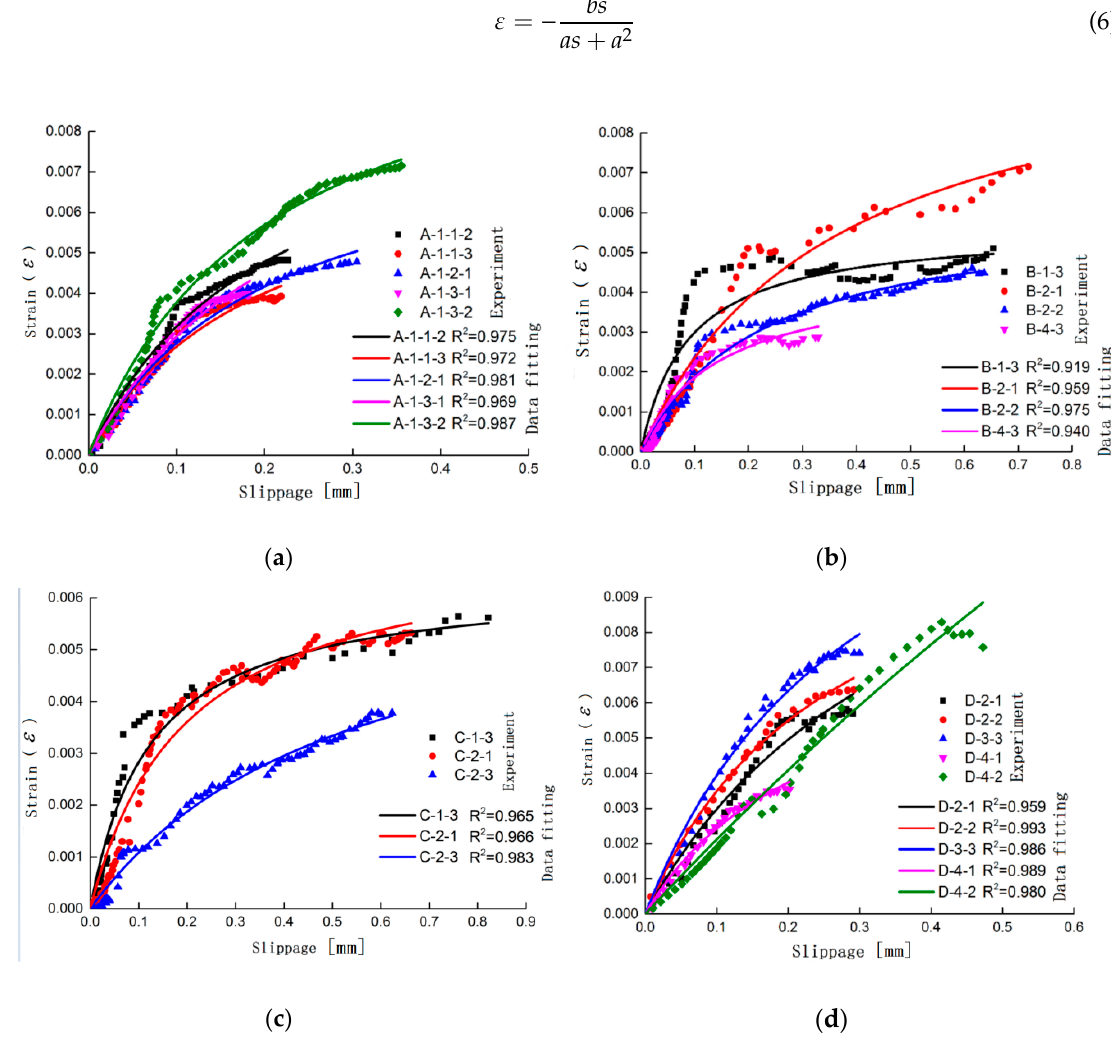
Figure 5. Experimental value vs. fitting curve of the strain-slip relationship: ( a ) Testing group of the sandblasted specimen; ( b ) Testing group of the specimen with di ff erent CFRP layers; ( c ) Testing group of the specimen with di ff erent CFRP fabric widths; and ( d ) Testing group of the specimen with di ff erent glue